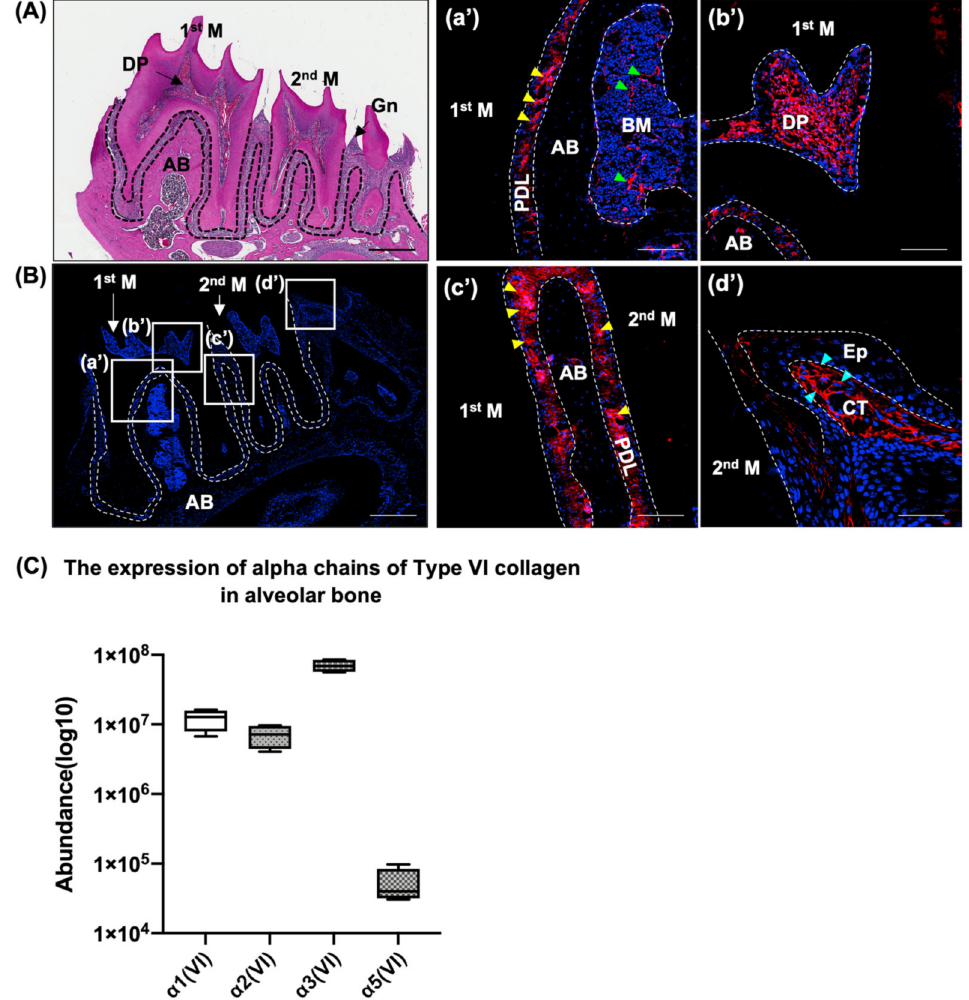
Figure 1. The expression of Type VI collagen in oral tissues. ( A ) H&E staining of mandibles from 3-month-old mice. Dashed line shows periodontal ligament. ( B ) Representative immunofluorescent staining image of Type VI collagen in mouse mandibles of 3-month-old mice ( n = 3). Magnified images of boxed areas in panel B are shown in ( a’ , b’ , c’ , d’ ). Nuclei were stained with DAPI (blue). Type VI collagen expression (red) in the periodontal ligament (PDL) (yellow arrowheads), bone marrow (BM) (green arrowheads), gingiva (Gn (blue arrowheads). ( C ) The abundance of alpha chains of Type VI collagen in murine alveolar bone from 6-week-old mice. M: molar, AB: alveolar